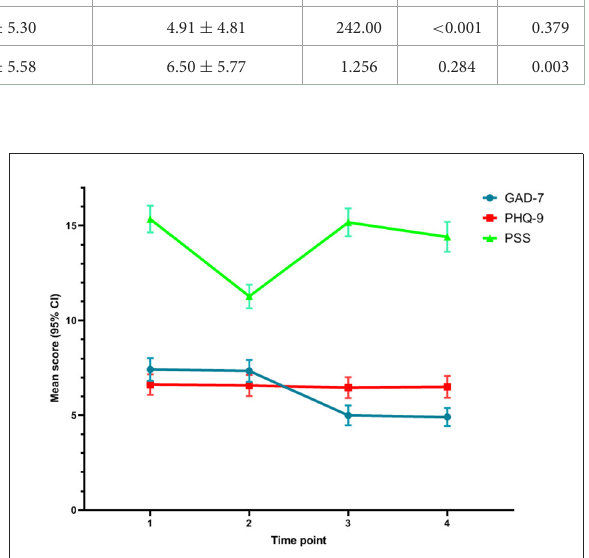
FIGURE3 The disparity among the four time-points on the mean scores of PSS, GAD-7, and PHQ-9. The results of paired comparisons on PSS: The score at T1 was significantly higher than that at T2 ( P < 0.001). The scores at T1 and T3 were not significantly different ( p = 0.243). The mean score at T1 was significantly higher than that at T4 ( P < 0.001). The score at T3 was significantly higher than that at T2 ( P < 0.001). The score at T4 was significantly higher than that at T2 ( P < 0.001). The score at T3 was significantly higher than that at T4 ( P < 0.001). The results of paired comparisons on GAD-7: The scores at T1 and T2 were not significantly different ( p = 0.310). The score at T1 was significantly higher than that at T3 ( P < 0.001). The score at T1 was significantly higher than that at T4 ( P < 0.001). The score at T2 was significantly higher than that at T3 ( P < 0.001). The score at T2 was significantly higher than that at T4 ( P < 0.001). The scores t T3 and T4 were not significantly different ( P = 1.000). The results of paired comparisons on PHQ-9: There were no significant differences between any scores on any stage ( P >